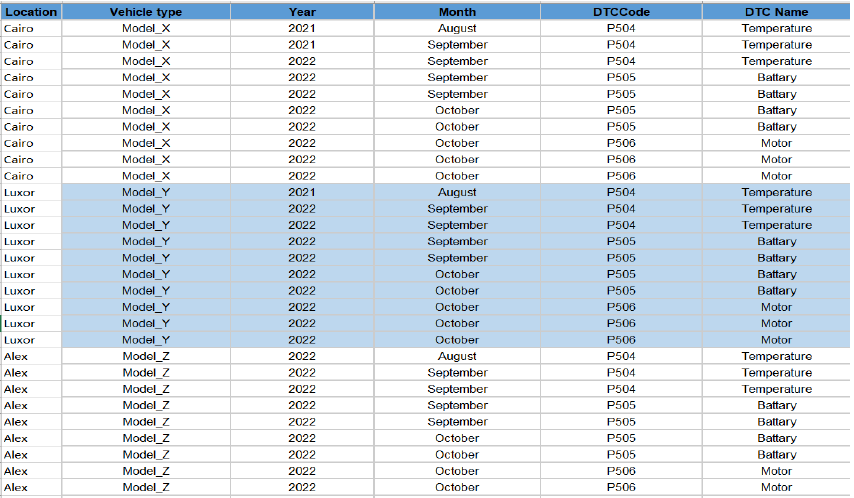
Figure 24. The report extracted from the Blockchain for many vehicle model and all logged DTC with timeline and